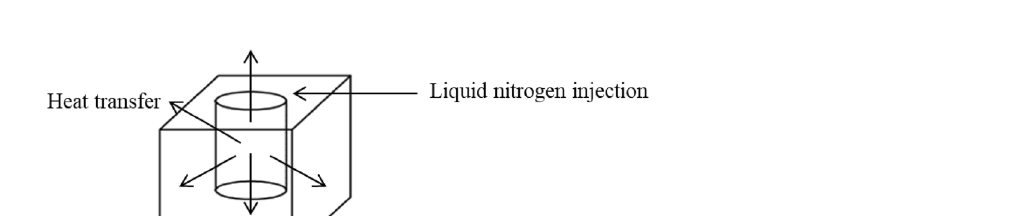
Figure 3. Liquid nitrogen fracturing drilling coal test device.